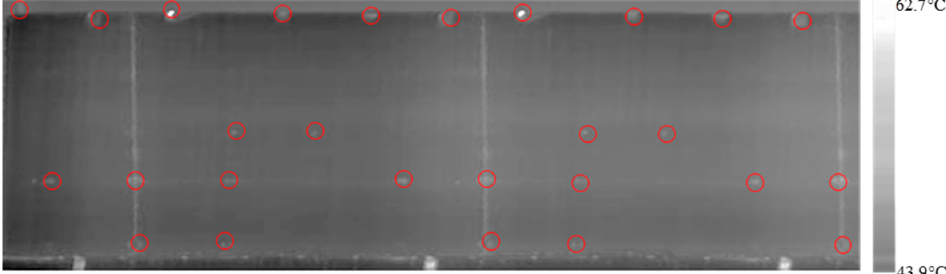
Figure 12. Stitched results of the fixed scan experiment for C10-sample (0.27 rpm & 500 W).